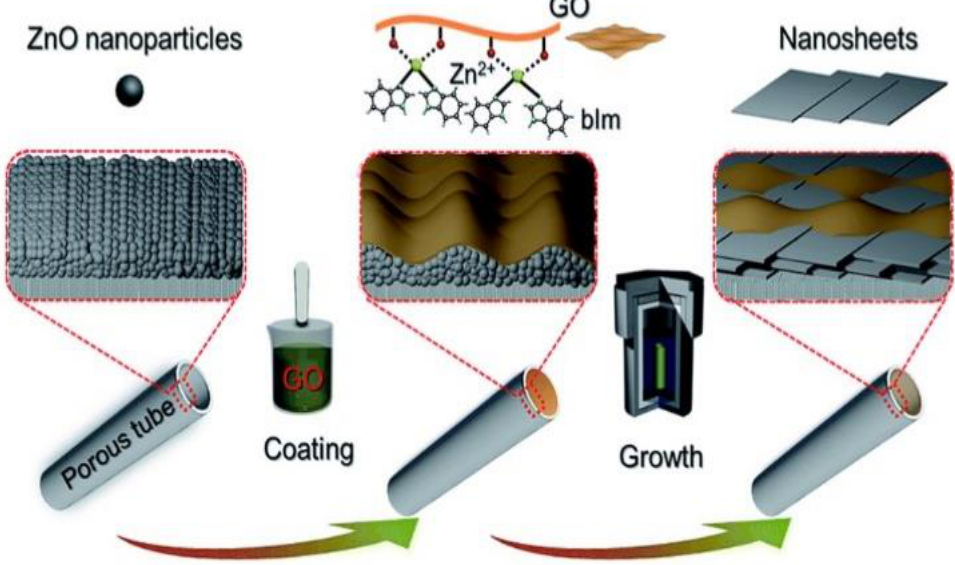
Figure 5. Scheme depicting the preparation procedure of highly oriented Zn 2 (bIm) 4 nanosheet membranes by ZnO self-conversion growth in a GO-confined space. Reproduced with permission from [21]. Copyright 2018, Royal Society of Chemistry.